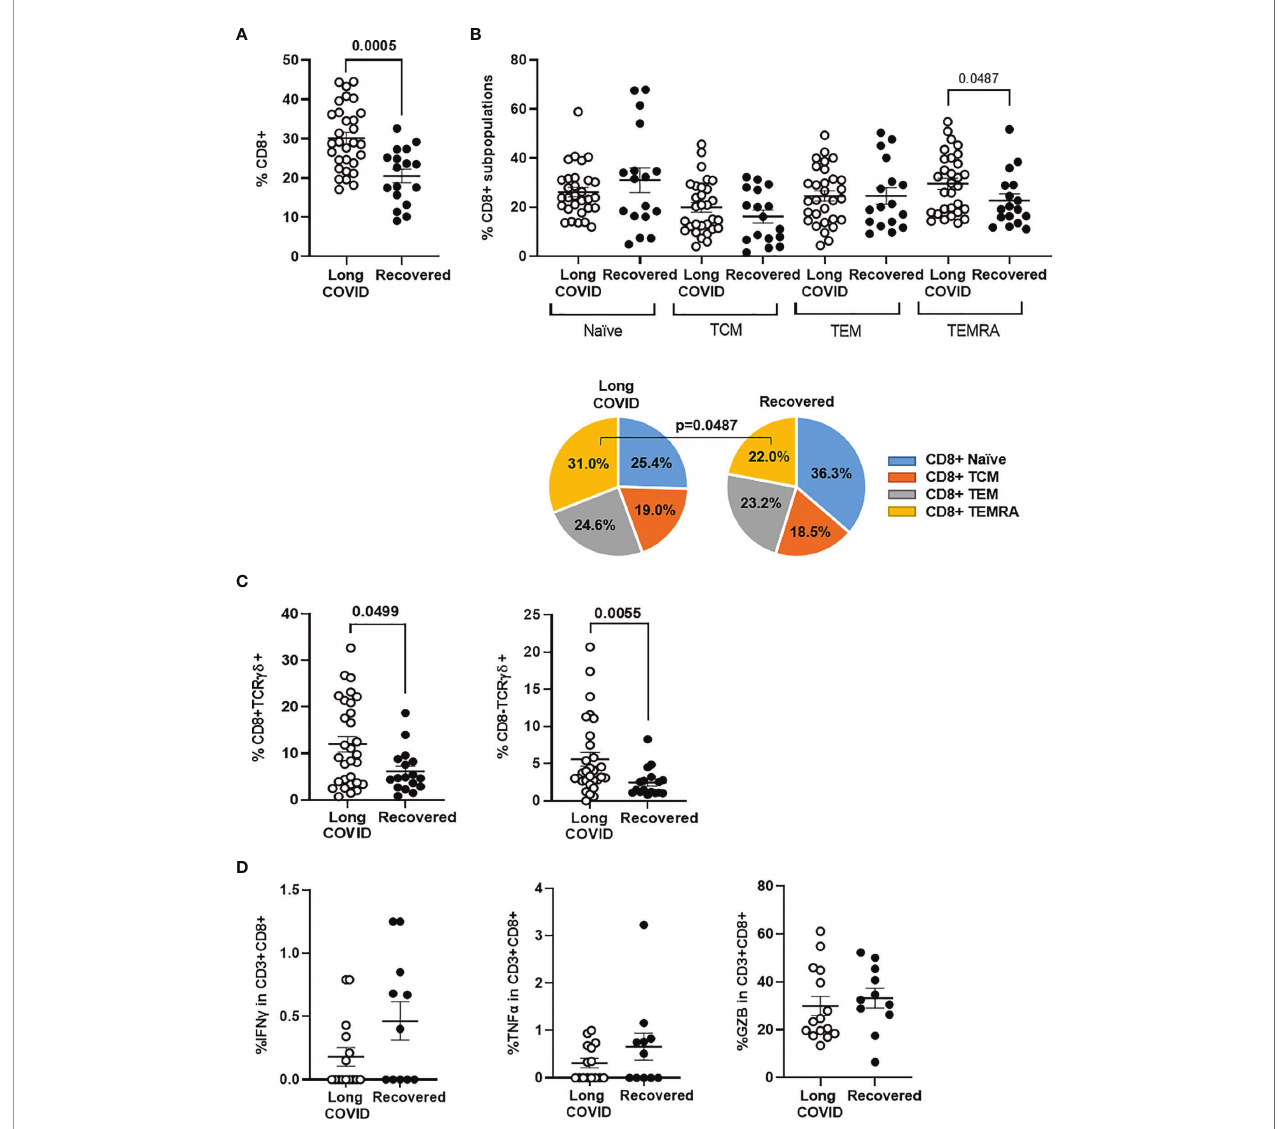
FIGURE 2 | Analysis of CD8 + T-cell populations in PBMCs from the Long-COVID and Recovered groups. Total levels of CD8 + T cells (A) and CD8 + T-cell memory subpopulations (B) were analyzed by fl ow cytometry. Individual data are shown in a dot plot, and mean data are shown in the pie charts. (C) The levels of CD8 ± TCR gd + were also determined by fl ow cytometry in both groups of individuals. (D) Quanti fi cation of the release of pro-in fl ammatory cytokines IFNg and TNFa, as well as the serine protease GZB from PBMCs from individuals with Long COVID and the Recovered participants after stimulation with a pool of nucleoprotein peptides from SARS-CoV-2. Each dot in the graphs corresponds to one sample, and lines represent mean ± SEM. Statistical signi fi cance was calculated using non- parametric Mann – Whitney test. PBMCs, peripheral blood mononuclear